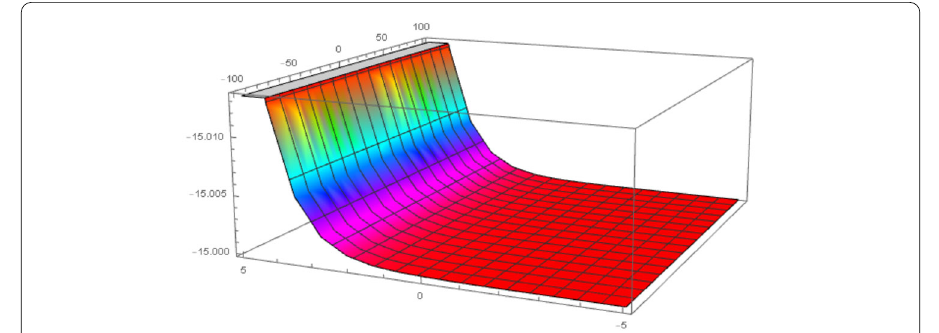
Figure 10 Solitonic solution of u 16 ( η ) for α = 0.25, a 0 = 0.5, λ = –1, b 0 = 2, V = 0.1, k = 3